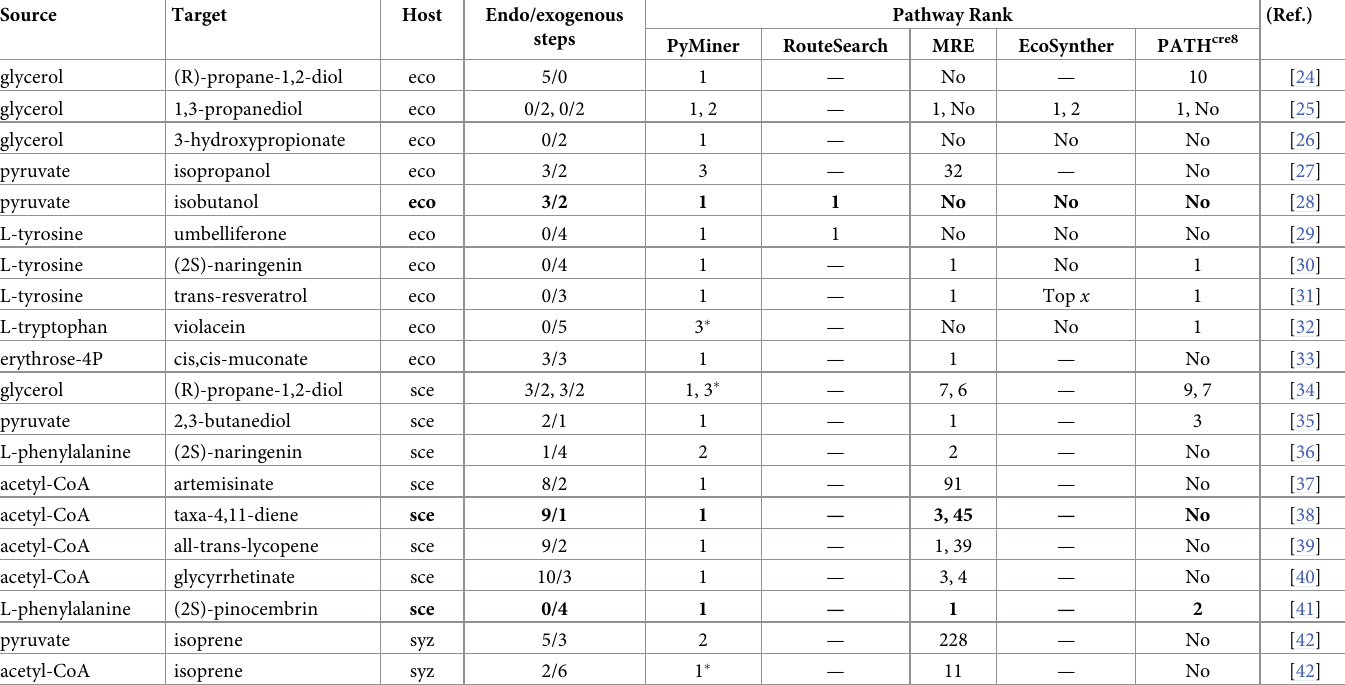
Table 3. Experimentally validated biosynthesis pathways retrieved by PyMiner and other